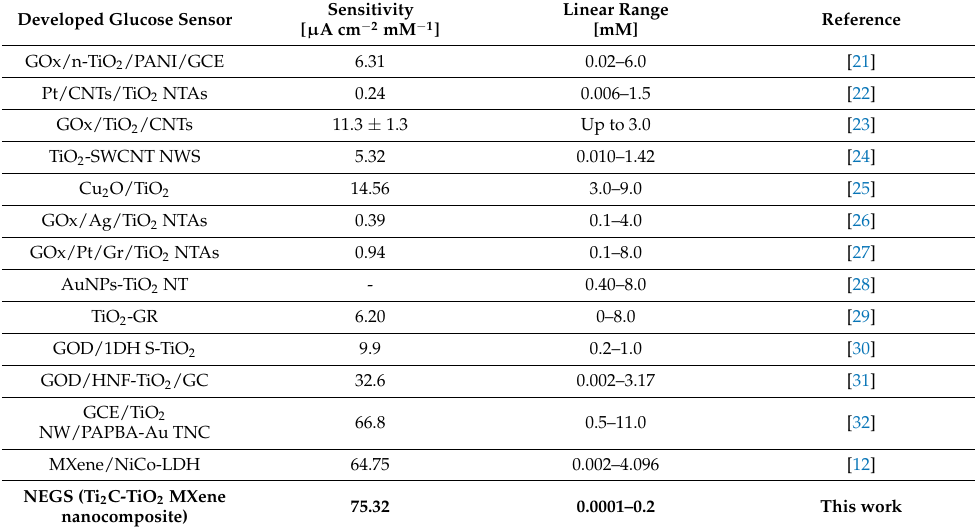
Table 1. Comparison of the developed sensor with previous